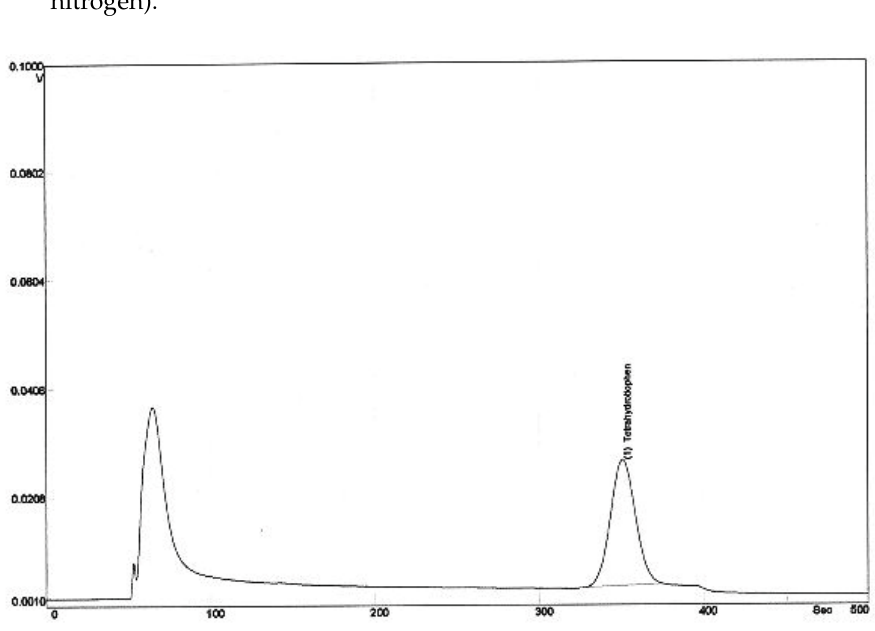
Figure 3. Chromatogram obtained using a Type I analyzer for M/H15 + THT, c THT = 7.74 ± 0.38 ppm.